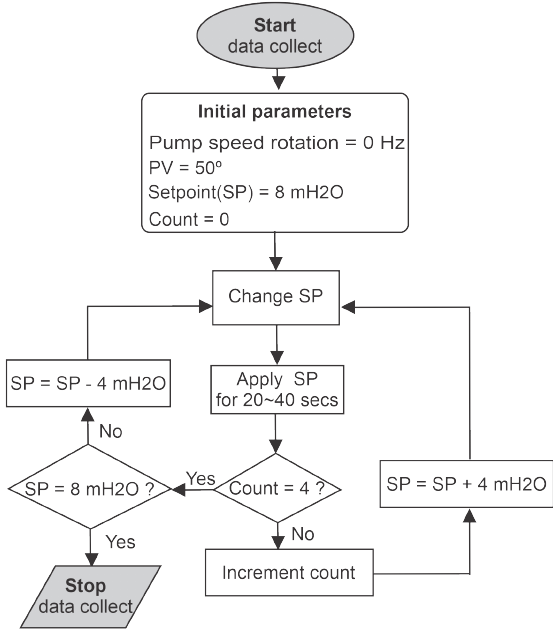
Figure 9. Data collection workflow for